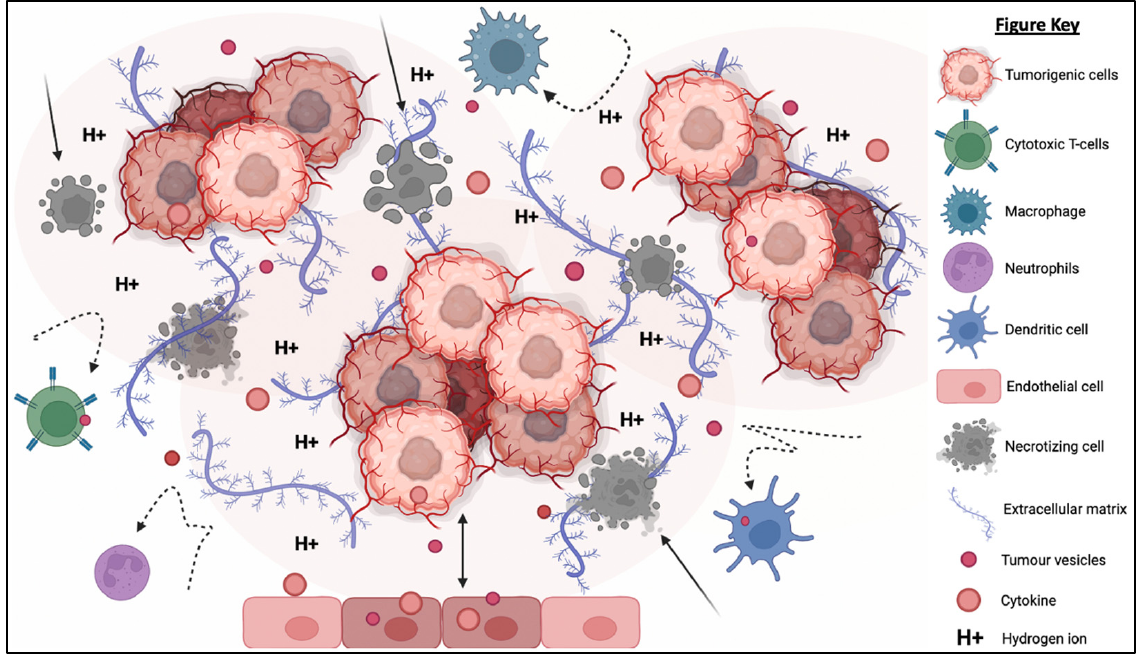
Figure 3. The tumorigenic cells are centered around faulty extracellular matrices, necrotic bodies, and a hypoxic and acidified microenvironment. This tumor microenvironment discourages immunoreactive cells from responding or otherwise entering the tumor to eradicate the tumor cells. At the same time, the hypoxic and acidic environment will induce cell death and exacerbate the inflammation. Moreover, tumor-derived extracellular vesicles will reprogram the host’s cells (e.g., endothelial cells) to support tumor development via increasing the secretion of growth factor, pro-angiogenic and anti-inflammatory